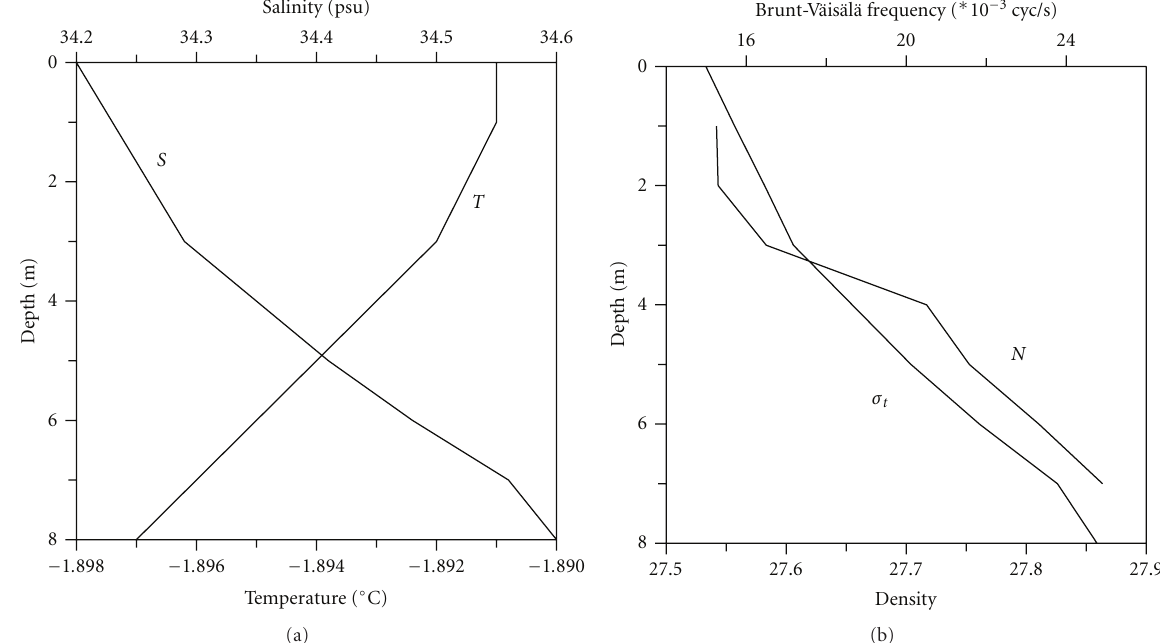
Figure 4: Vertical distribution of temperature ( T ), salinity ( S ), density ( σ t ), and Brunt-V¨ais¨al¨a frequency ( N ) in the study